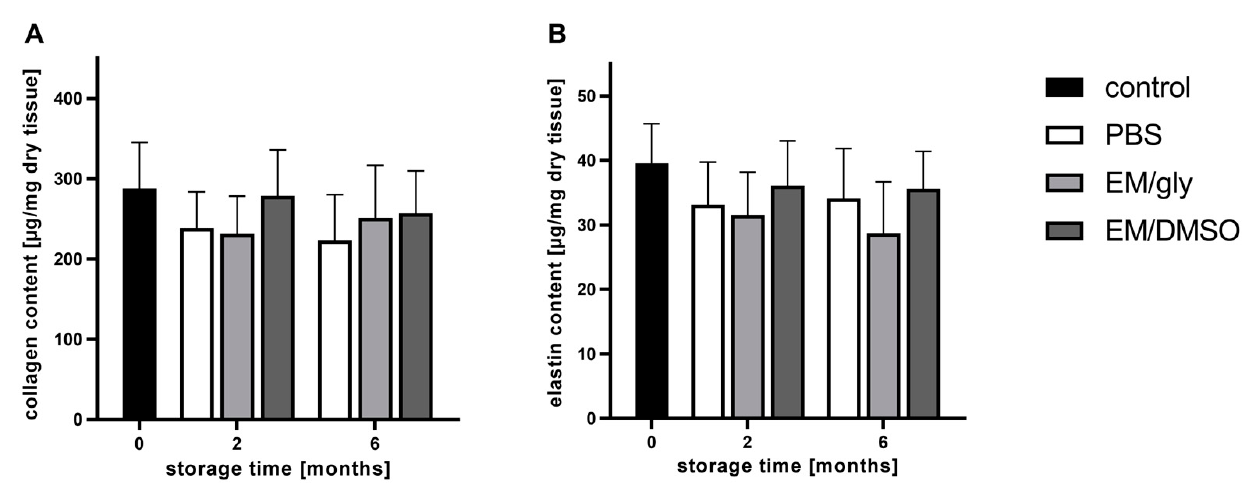
Figure 3. Collagen ( A ) and elastin ( B ) content of fresh PDC (control) and PDC stored for two and six months in PBS (at 4 °C), in EM/gly (at − 80 °C) and in EM/DMSO (at − 196°C). There were no significant differences between the groups (collagen: p ≥ 0.18, elastin p ≥ 0.13); collagen: n = 10, elastin n = 6.